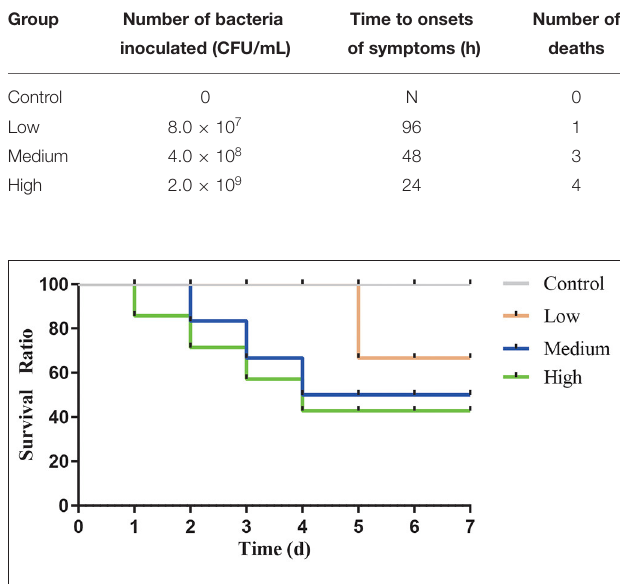
FIGURE 4 | The survival curve after intragastric administration of Clostridium perfringens